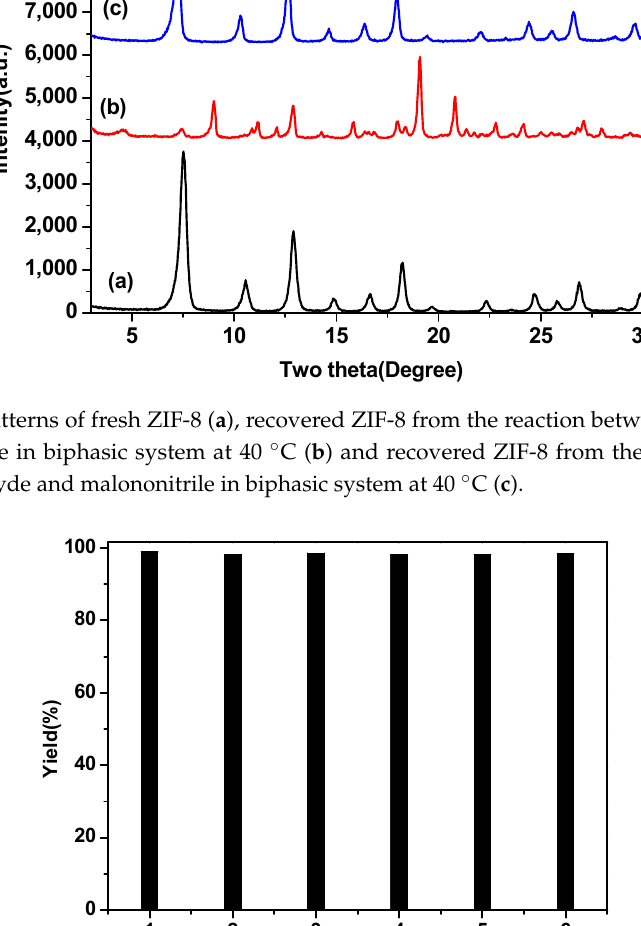
Figure 9. TEM images of fresh ZIF-8 ( A ), recovered after three cycles ( B ) and after six cycles ( C ) from the Knoevenagel condensation between 2-nitrobenzaldehyde and malononitrilein water at 40 °C. 0